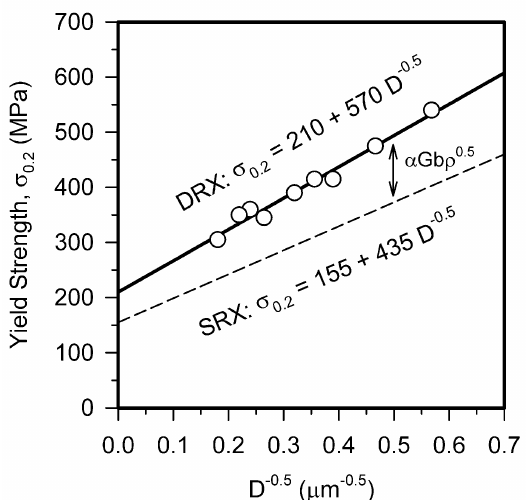
Figure 9. The effect of the DRX grain size on the yield strength of a high-Mn steel processed by hot compression. The coarse remnants of the original grains contain a high density of low-angle dislocation sub-boundaries (Figure 8a). Thus, the partially recrystallized microstructure is characterized by the high dislocation density. Figure 4c,d suggests that other samples with microstructures, which were completely recrystallized during hot compression, also contain a relatively high dislocation density in the grain interiors as proved by numerous low-angle sub-boundaries. Therefore, the difference in the yield strength of the samples with statically and dynamically recrystallized microstructures can be expressed by a Tailor-type relationship [37],